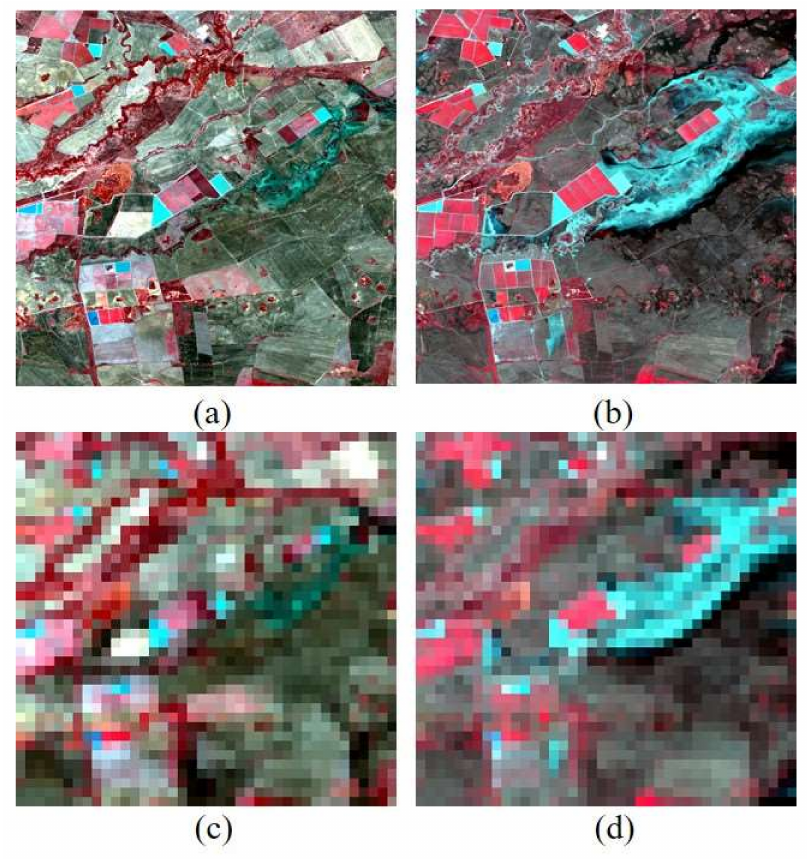
Figure 7. An example of flood event happening during spatiotemporal data fusion: using ( a ), ( c ), and ( d ) to predict ( b